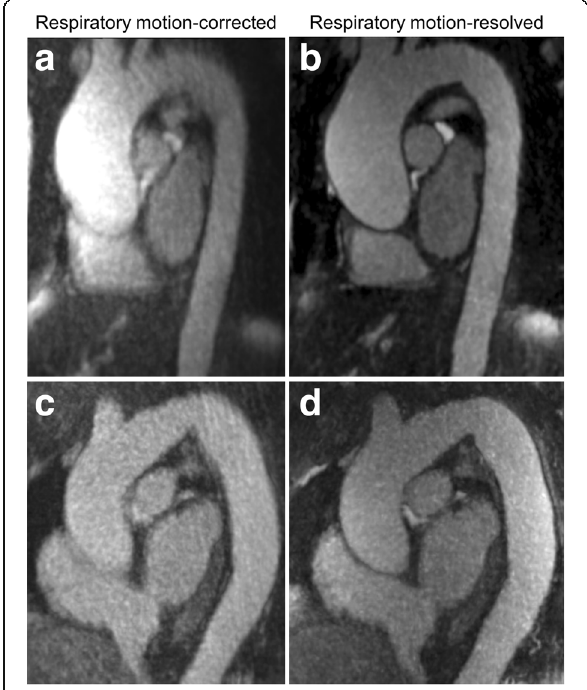
Fig. 2 Representative motion-corrected ( a , c ) and motion-resolved ( b , d ) images from a 74-year-old woman ( a , b ) and a 59-year-old woman ( c , d ), both with ascending aorta dilation. Maximum intensity projection images displayed as 3-mm thick slabs are shown in the candy cane view of the aorta. Substantially improved image sharpness can be observed with motion-resolved reconstruction in both cases ( b , d ) along with improved signal uniformity especially in the first patient ( a ). Note that data from the same image acquisition are used but processed differently